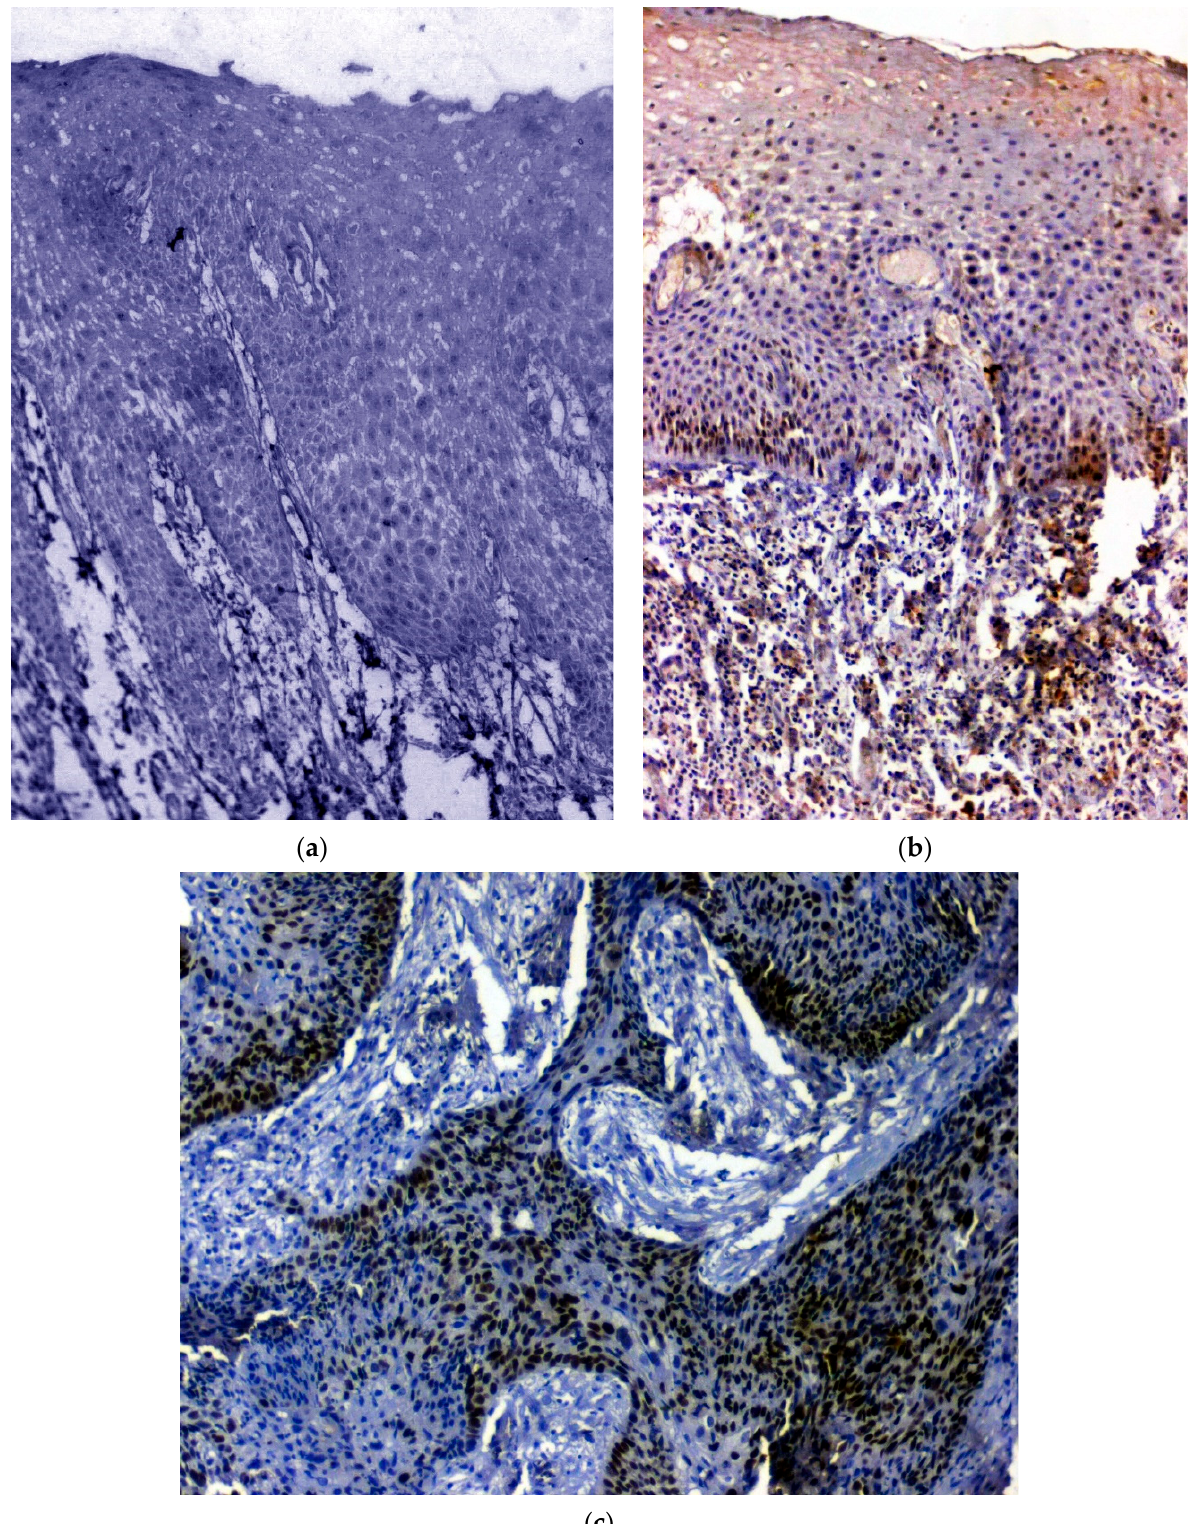
Figure 2. ( a ) IHC for SOX 2 in healthy control hyperplastic oral epithelium, showing negative stain, ( b ) IHC for SOX 2 in oral submucous fi brosis showing intense nuclear positivity, and ( c ) IHC for SOX 2 in MDSCC showing intense nuclear positivity (under 20× magni fi cation).